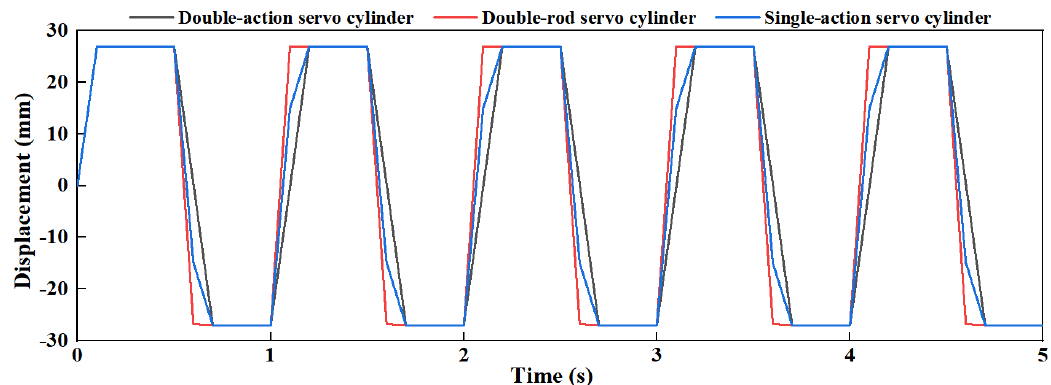
Figure 10. Response characteristics of the electrohydraulic servo all-hydraulic forging hammer.